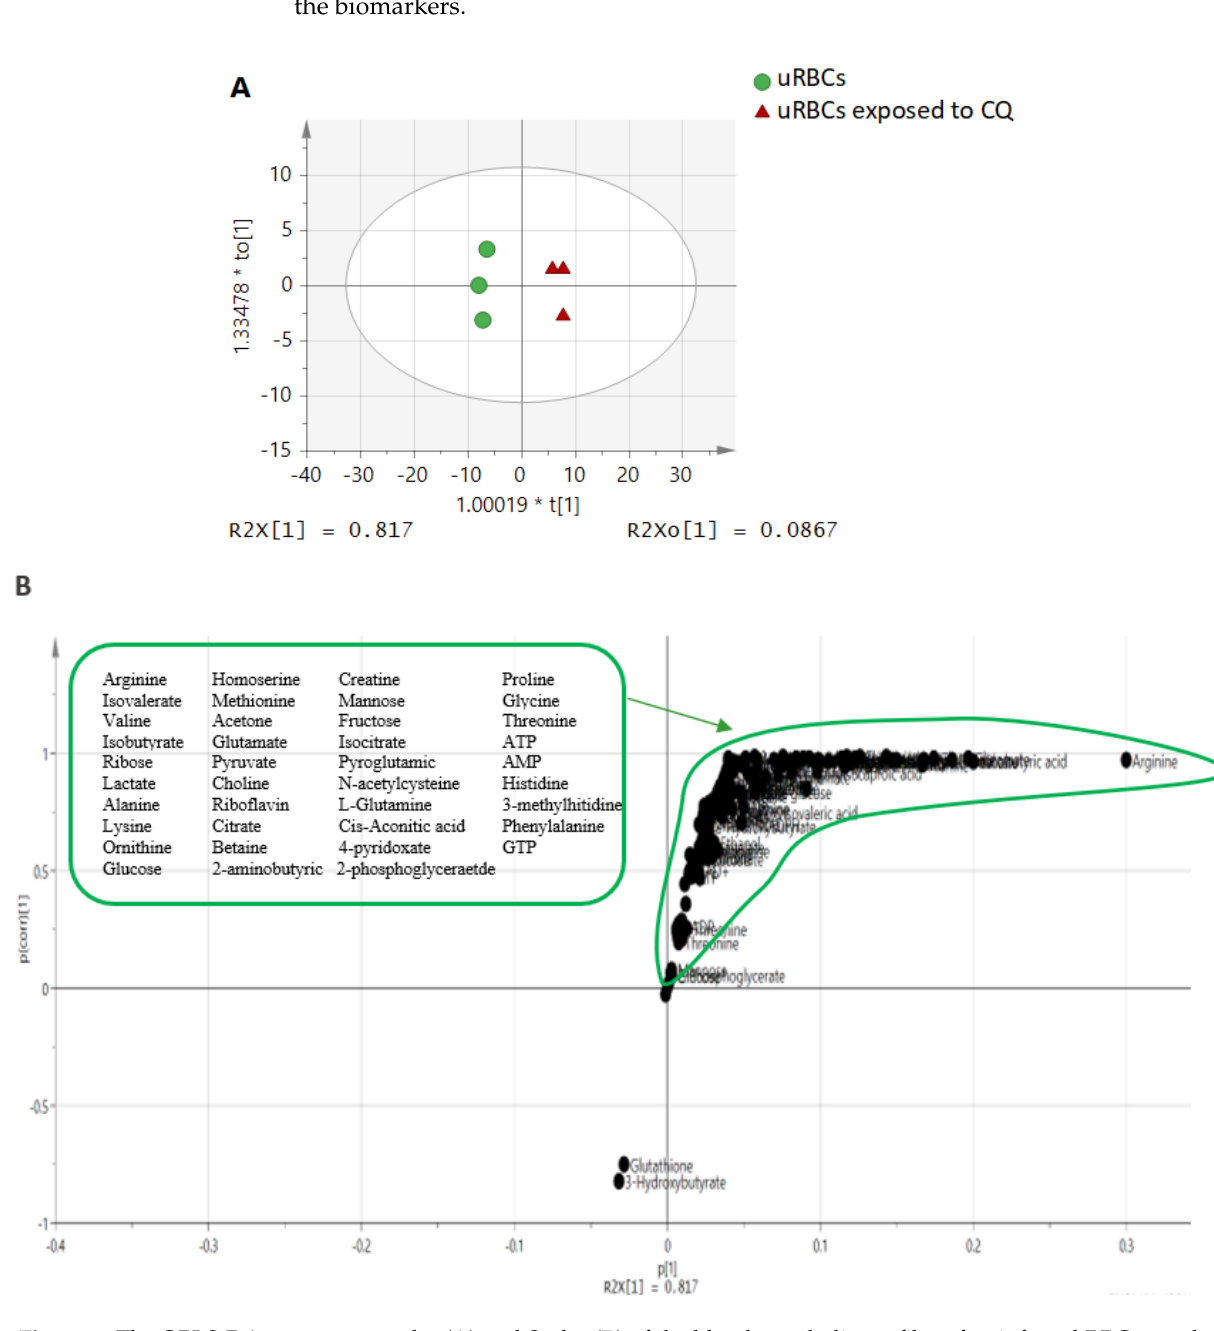
Figure 4. The OPLS-DA score scatter plot ( A ) and S-plot ( B ) of the blood metabolic profiles of uninfected RBC samples. uRBCs; uninfected red blood cells, CQ; chloroquine.